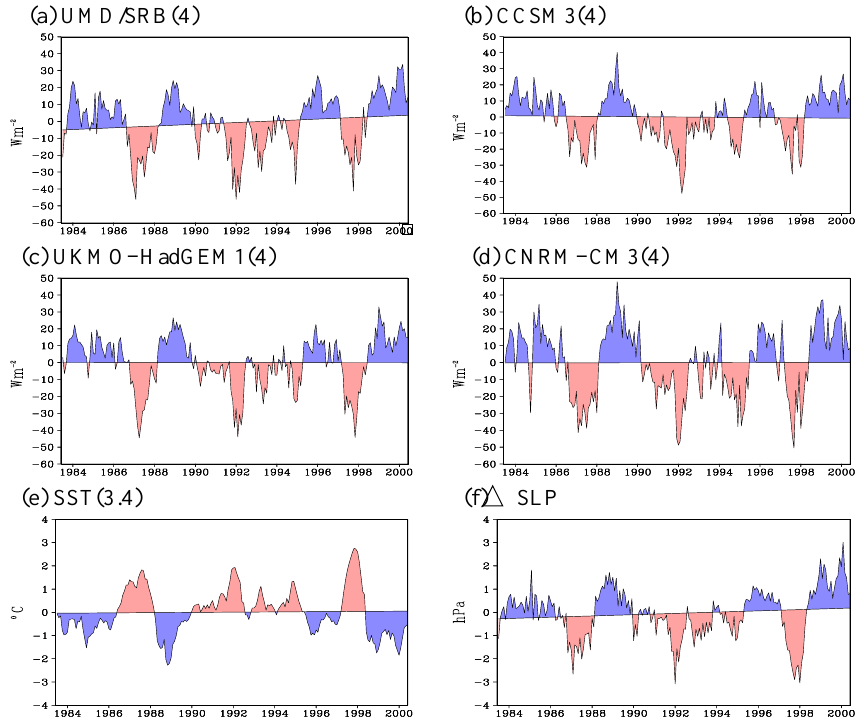
Fig. 6. Time series of SW ↓ surf anomalies corresponding to El Ni˜no 4 region for: (a) UMD/SRB; (b) CCSM3; (c) UKMO-HadGEM1; (d) CNRM-CM3 in Wm − 2 ; (e) time series of SST anomalies corresponding to El Ni˜no 3.4 region in ◦ C; (f) time series of 1 SLP or the difference in sea level pressure over (160 ◦ W to 80 ◦ W, 5 ◦ S to 5 ◦ N) and over (80 ◦ E to 160 ◦ E, 5 ◦ S to 5 ◦ N). The straight lines represents the trend of the